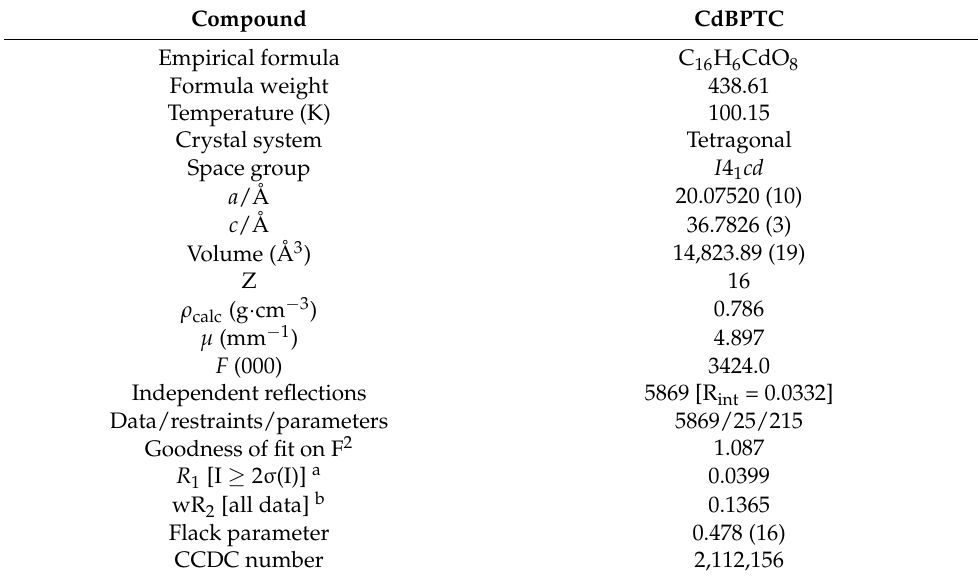
Figure 2. The simplified four-connected node of the mononuclear Cd 2+ unit ( a ) and two 3-connected linkers ( b ). The (4, 3, 3)-connected topological along b axis ( c ) and c axis ( d ). Table 1. Crystal data and structure refinement results for